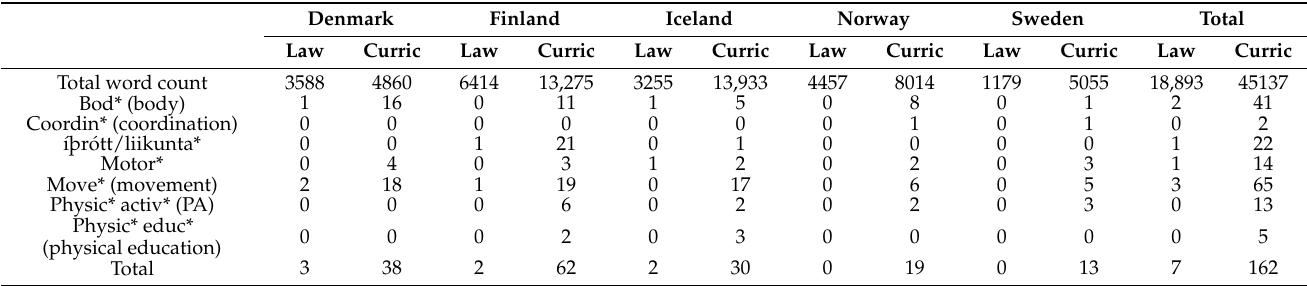
Table 1. The frequency of MoPA-related terms identified in policy documents from Denmark, Finland, Iceland, Norway and Sweden. Denmark Finland Iceland Norway Sweden Law Curric Law Curric Total word